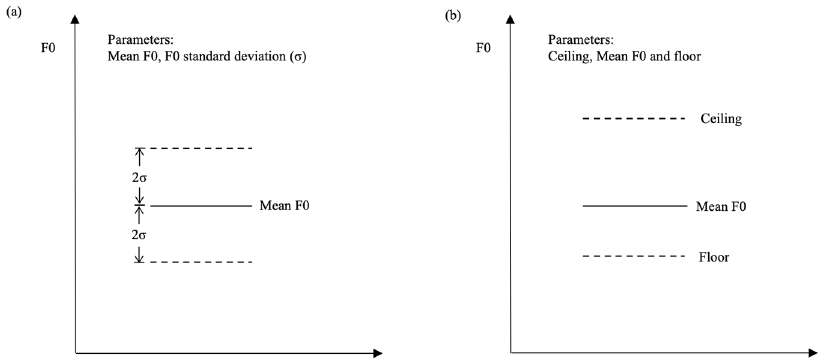
Figure 1. The measurement of F0 range: ( a ) in the initial model; ( b ) in the refined